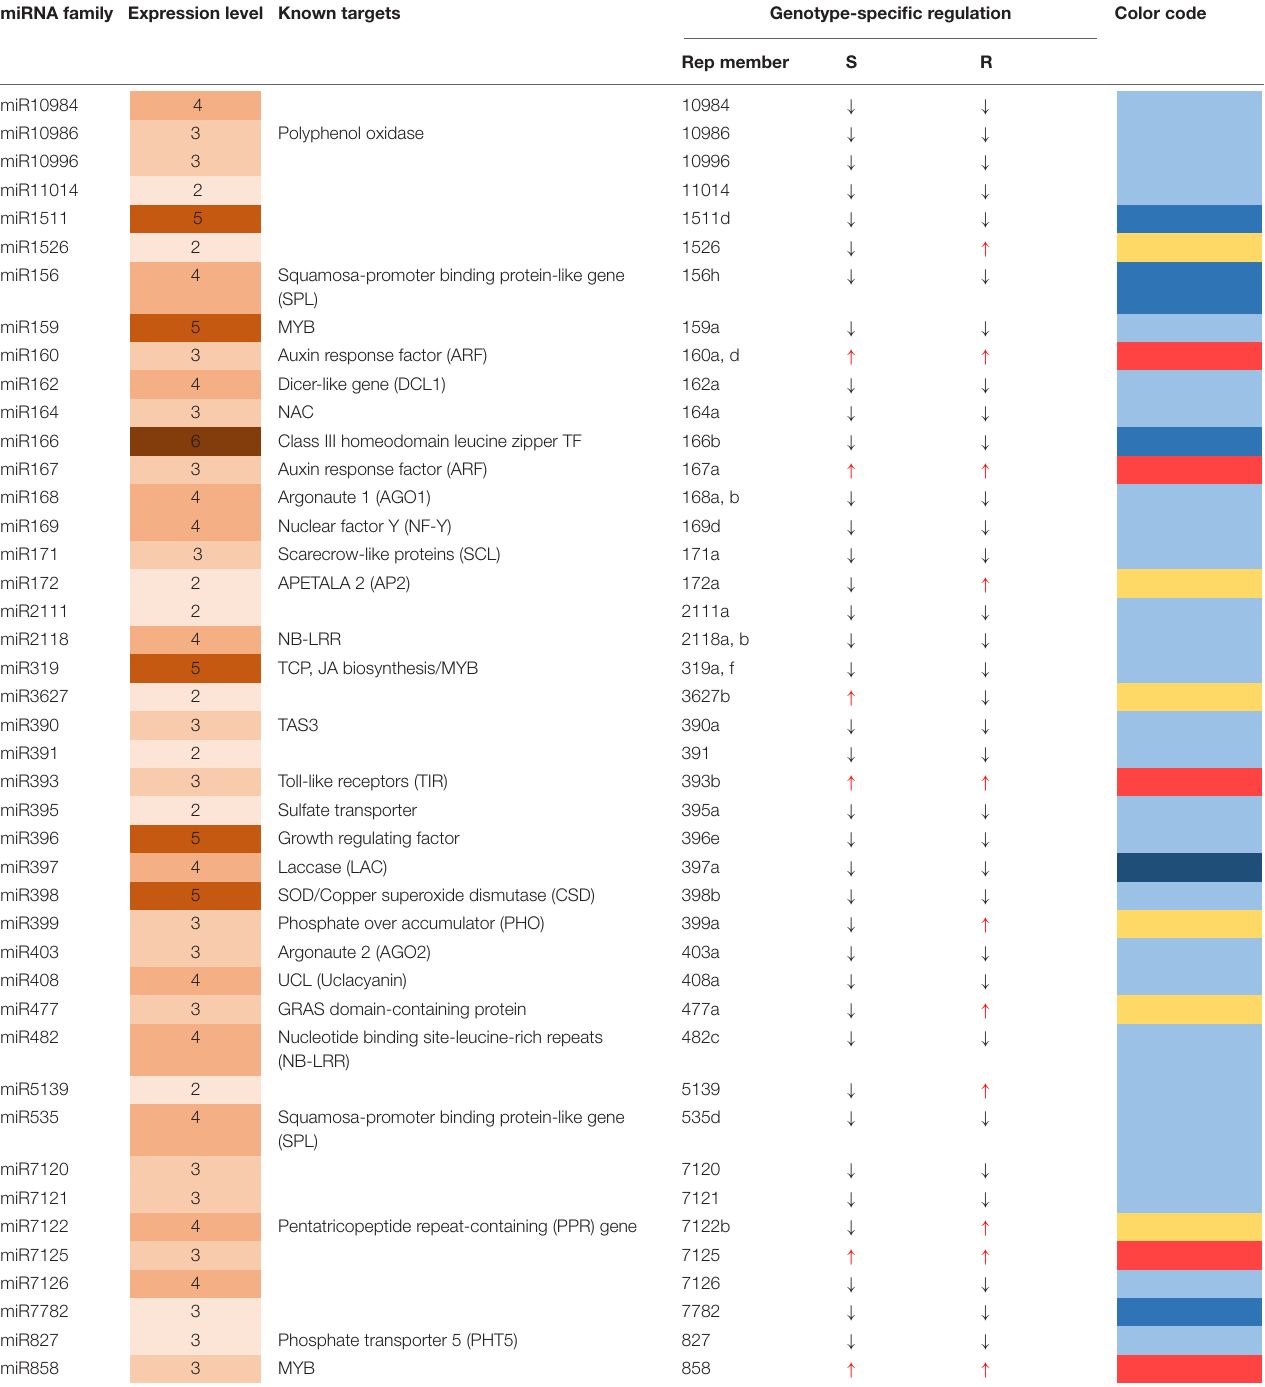
TABLE 2 | Genotype-specificity of miRNA regulation in apple roots in response to Pythium ultimum infection. miRNA family Expression level Known